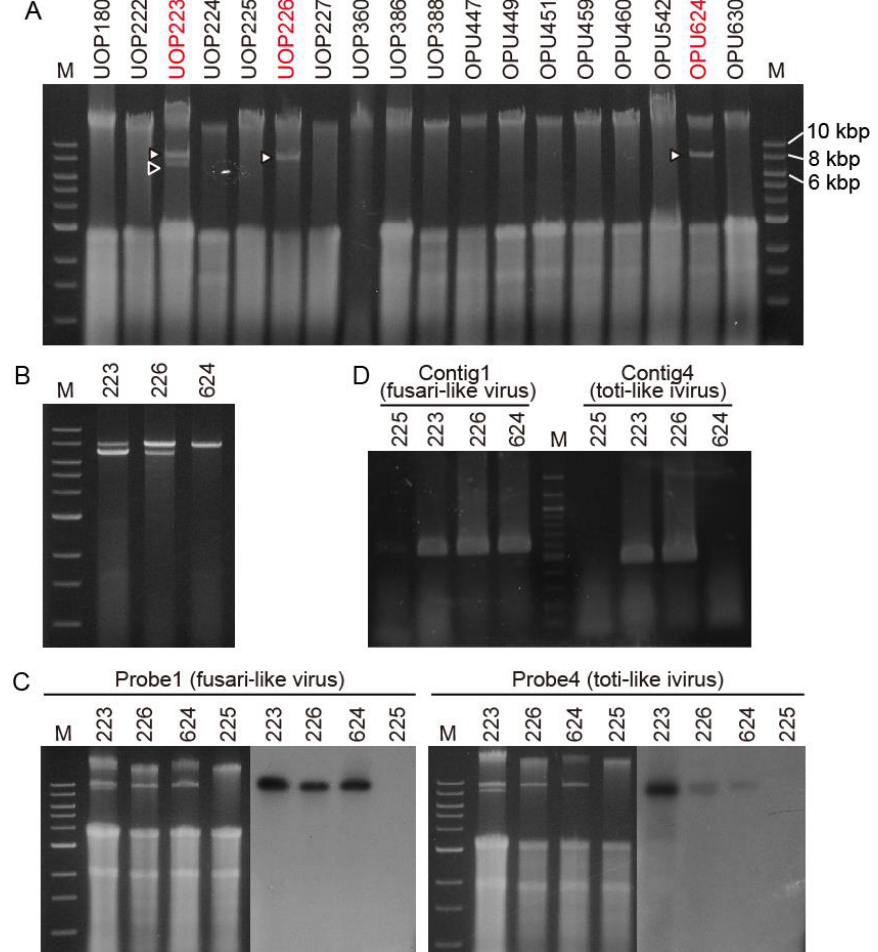
Figure 1. ( A ), Presence or absence of virus-like dsRNA in total nucleic acids extracted from G. ultimum isolates in Japan and Norway. ( B ), dsRNAs purified by CF11 cellulose column chromatography. ( C ), Northern blot analysis of fusari-like Pythium ultimum RNA virus 1 (PuRV1) and toti-like Pythium ultimum RNA virus 2 (PuRV2). dsRNAs were observed using 1% ( v / v ) agarose gel electrophoresis with ethidium bromide staining. M is a DNA marker (NEB, 1 kbps). ( D ), The RT-PCR analysis of fusari-like PuRV1 and toti-like PuRV2 using specific primer sets. M is a DNA marker (NEB, 100 bps).